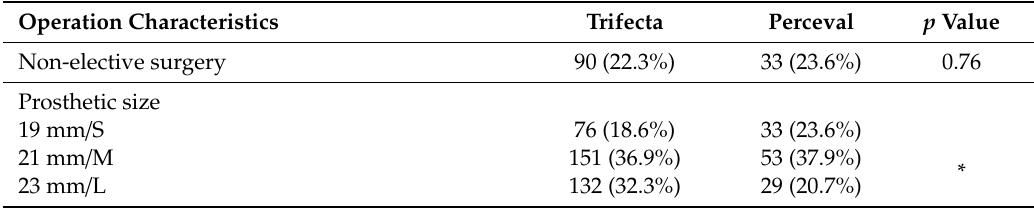
Table 2. Operation characteristics and postoperative